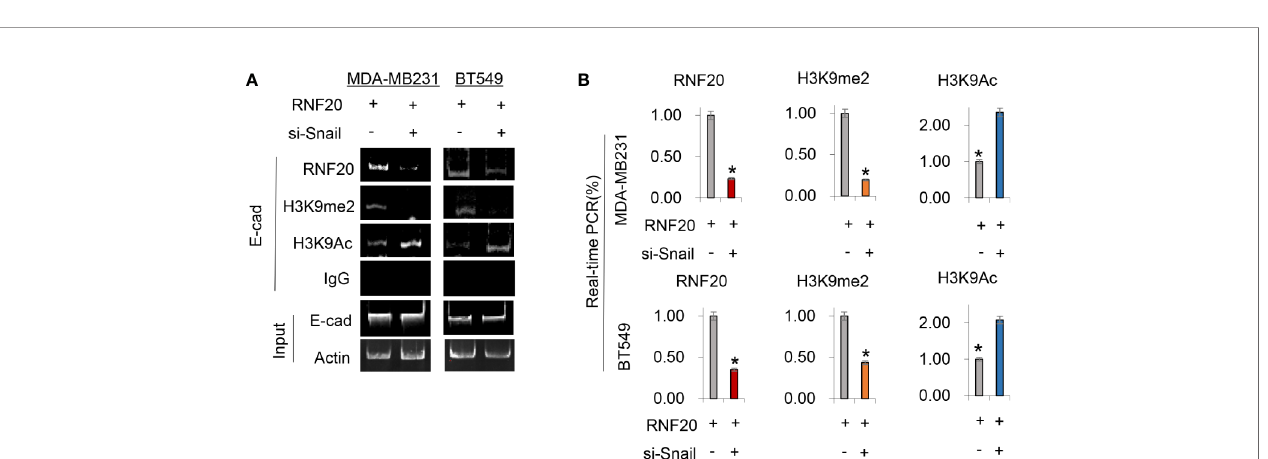
FIGURE 4 | RNF20 interacts with G9a. 293T cells were transiently coexpressed with Flag-tagged G9a, HA-tagged RNF20. Cell extract were immunoprecipitated separately with Flag or HA antibodies, and the associated RNF20 and G9a were examined by Western blotting